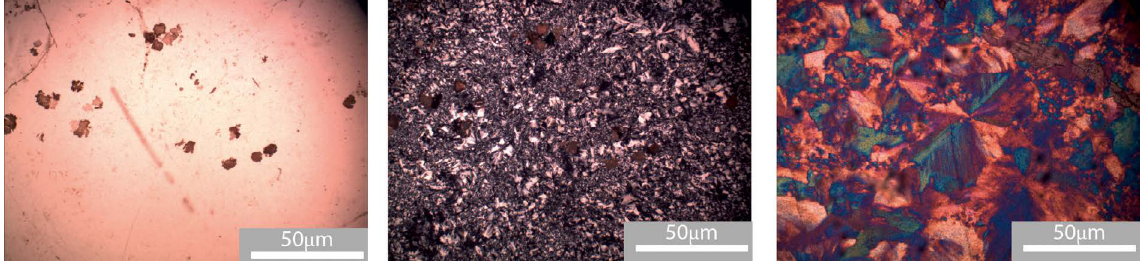
Figure 11. Thin sections of Tossa chert type. Left: Calcite intraclasts. Centre: Isometric microquartz. Right: Detail of lutecite replacing a gypsiferous